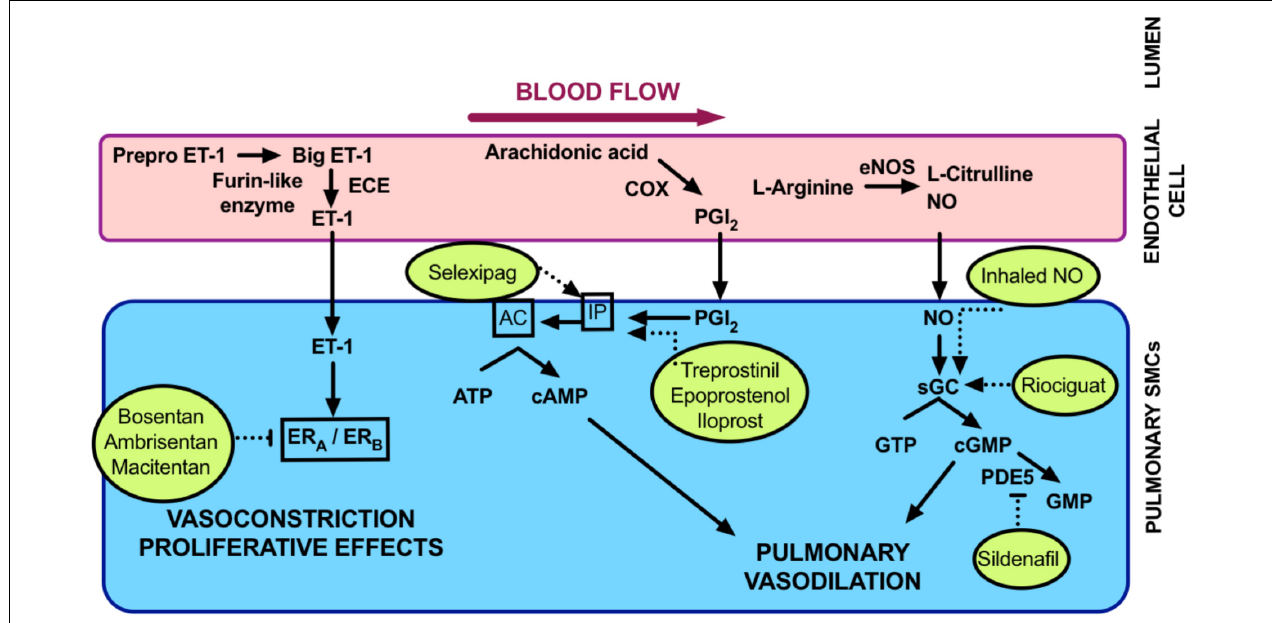
FIGURE 2 | Summary of current PAH treatments. Currently licensed treatments for PAH are shown inside the circles with broken lines indicating their mode of action within vascular signaling pathways. AC, adenylate cyclase; cAMP, cyclic adenosine monophosphate; cGMP, cyclic guanosine monophosphate; COX, cyclooxygenase; ECE, endothelin converting enzyme; eNOS, endothelial nitric oxide synthase; ET-1, endothelin; ER A , B , endothelin receptor A,B; GTP, guanosine triphosphate; IP, inositol monophosphate; NO nitric oxide; PDE5, phosphodiesterase 5; PGI 2 , prostacyclin; sGC soluble guanylate